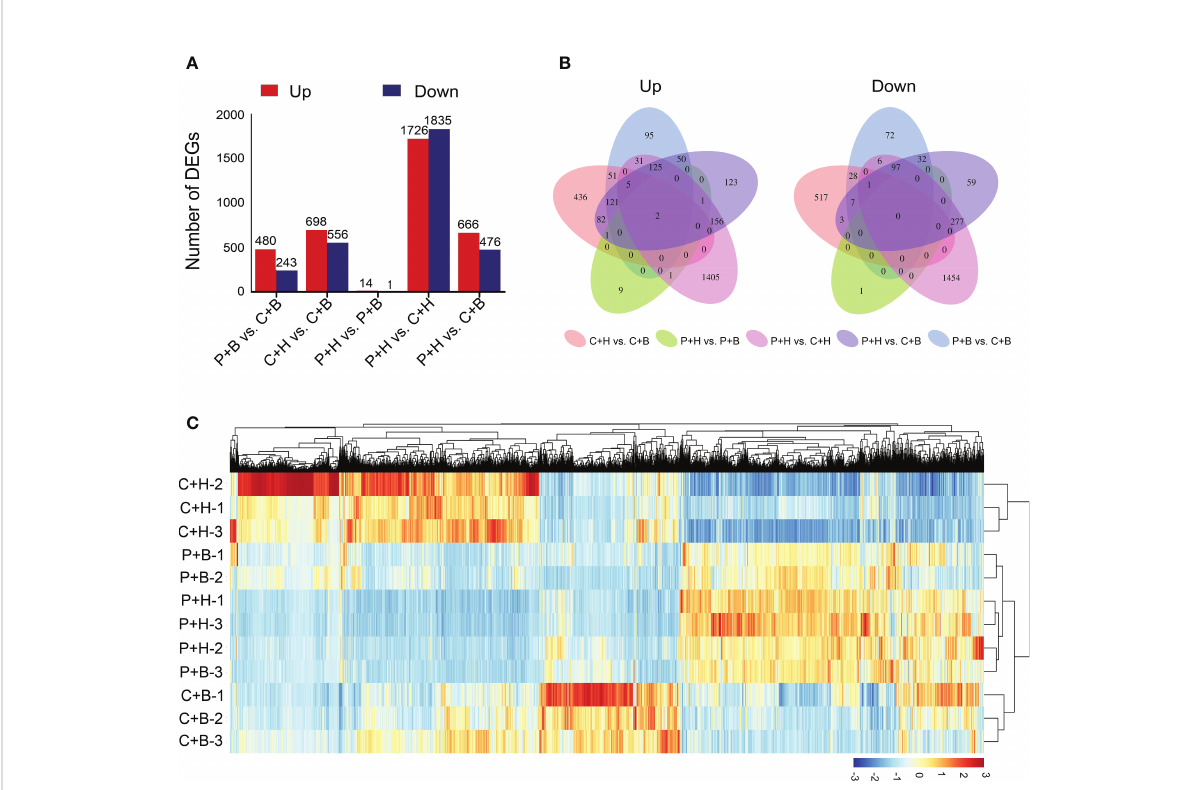
FIGURE 2 Statistical analyses of differentially expressed genes (DEGs). (A) The number of DEGs in fi ve comparisons. (B) Venn diagrams showed the relationship of DEGs among fi ve comparisons. The fi rst venn diagram represents all up-regulated DEGs, and the second venn diagram represents all down-regulated DEGs. (C) The heatmap of hierarchical clustering of gene expression pro fi les in these four treatments with three biological replicates. The color scale (blue to red) represents low to high gene expression intensities. P+H, PBS solution + H 2 O; P+B,